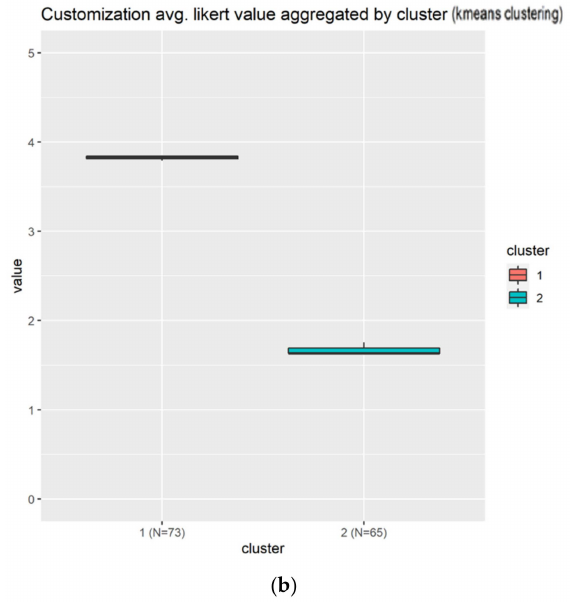
Figure 18. Results from customization. There are only two clusters, with a clear separation. The ( a ) subplots show the results based on each question, meanwhile the ( b ) shows the information condensed in boxplots.